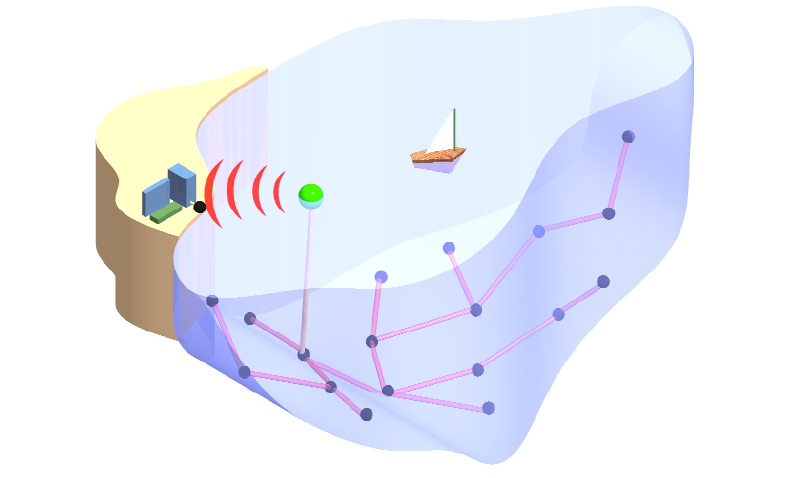
Figure 1 . An illustrative drawing of the aqueous sensor network. The nodes (blue spheres) are scattered throughout the lake and communicate acoustically (red lines). The uplink node (green sphere) contains both an acoustic transducer, and a RF transceiver through which it communicates to the host node (black sphere) that is directly attached to a